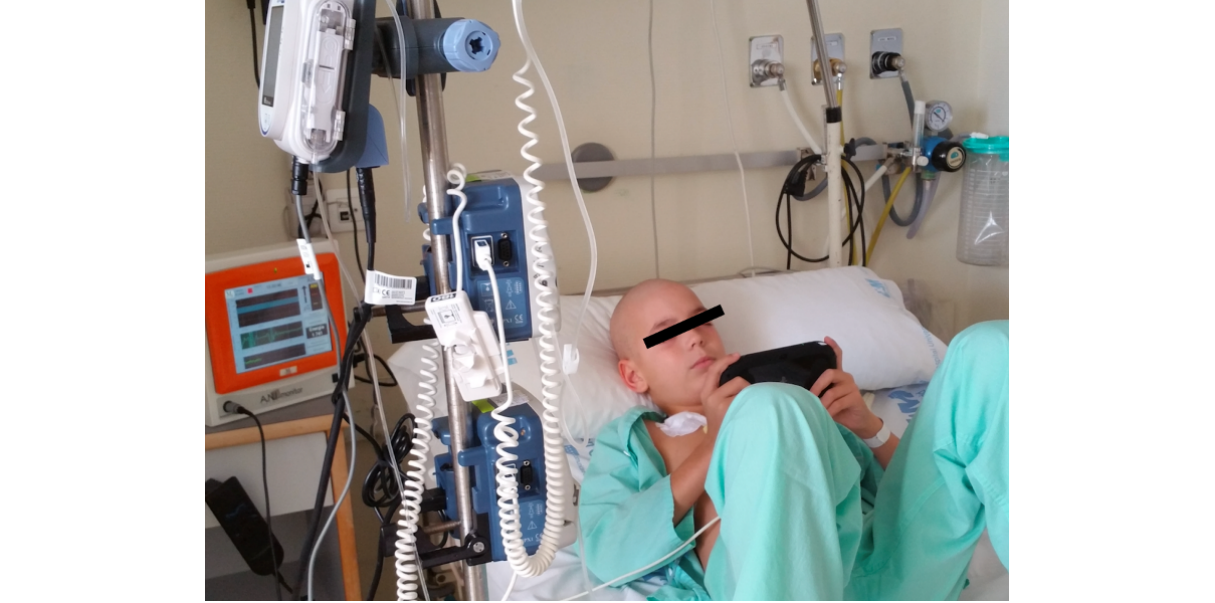
Figure 1. Child playing an electronic video game while being fitted with a patient-controlled analgesia pump and monitored for respiratory heart rate